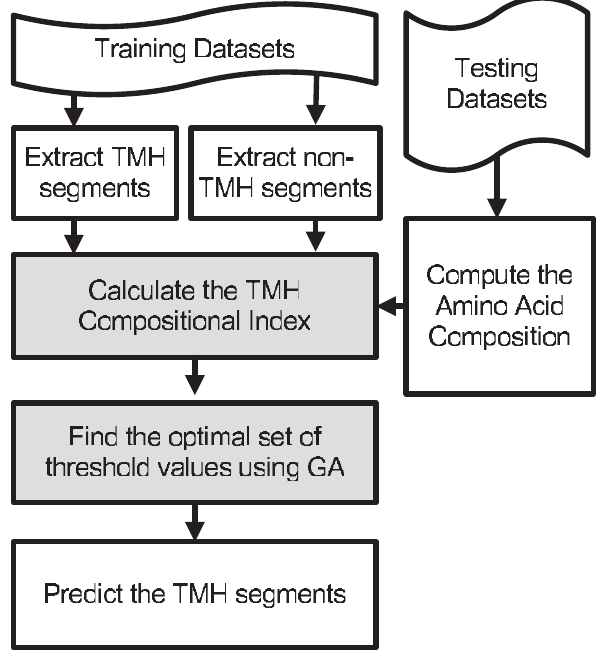
Figure 1. TMHindex overview.